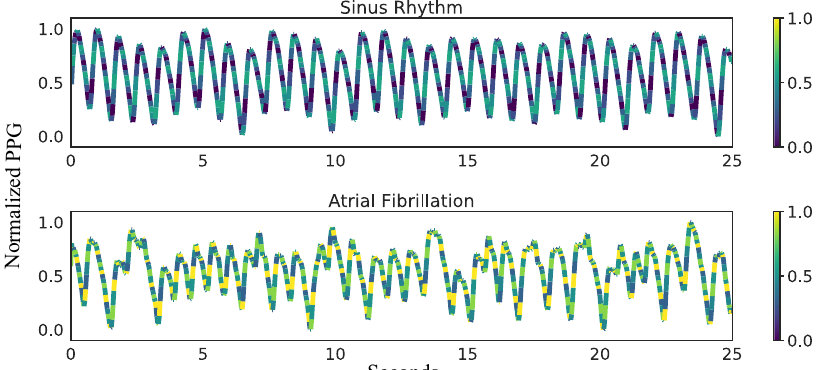
Fig. 3 Differences in class activation map by rhythm classi fi cation. Example of signals from held-out test dataset. The predicted class score is mapped back to the last convolutional layer to generate the class activation maps (CAMs). The CAM highlights the class-speci fi c discriminative regions between sinus (top) and atrial fi brillation (bottom).